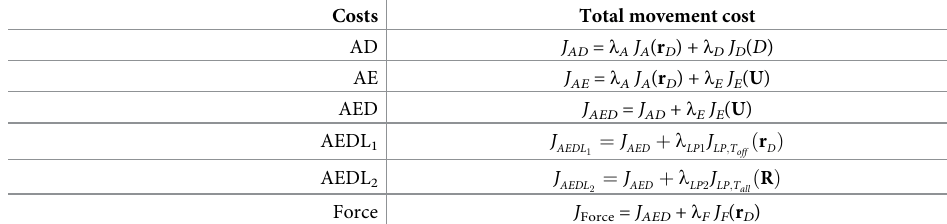
Table 2. Six different cost functionals, all optimized to control saccades by tuning the weights, λ α for the contrib- uting terms. Each total cost includes the accuracy cost, but differs in the contribution from other kinematic terms. AD: accuracy and duration; AE: accuracy and energy; AED: accuracy, energy and duration; AEDL 1 : AED with Listing’s law at saccade offset only; AEDL 2 : AED with Listing’s law for the entire trajectory. The weights are the (two to four) free parameters for the optimal